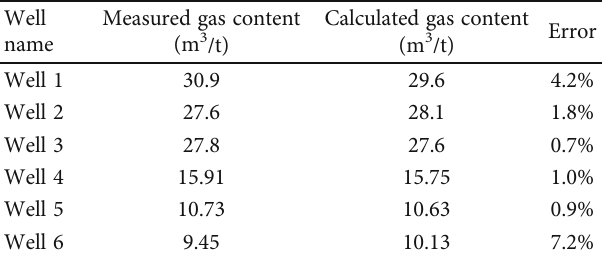
(Table 5). The error in Table 5 are de fi ned as Measured gas content − Calculated gas content j j Error = Measured gas content